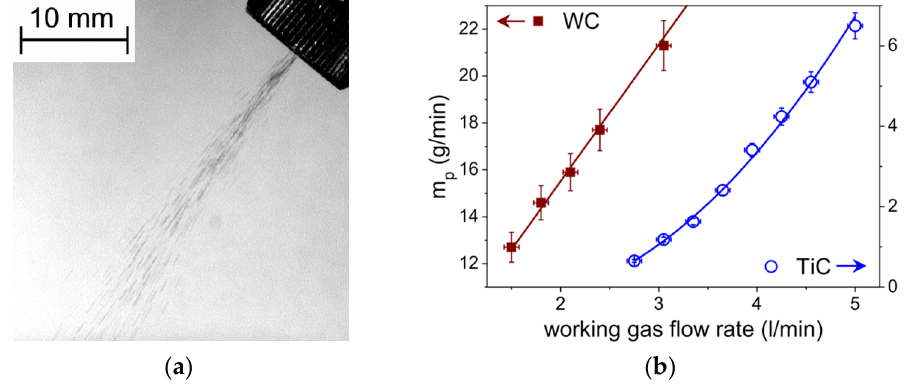
Figure 2. ( a ) Photograph of the WC powder stream (exposure time 1 ms); ( b ) Dependencies of powder feed-rate vs. working gas flow rate for TiC and WC